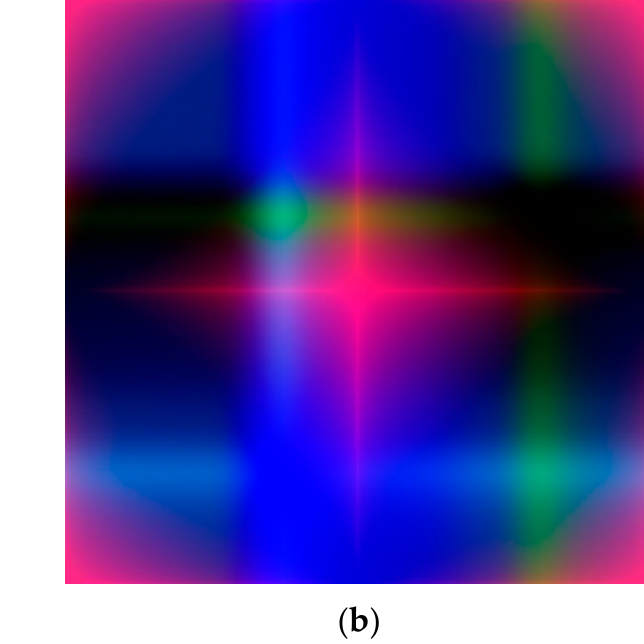
Figure 7. Gramian angular field (GAF) transformation of an I–V cycle into an RGB image.